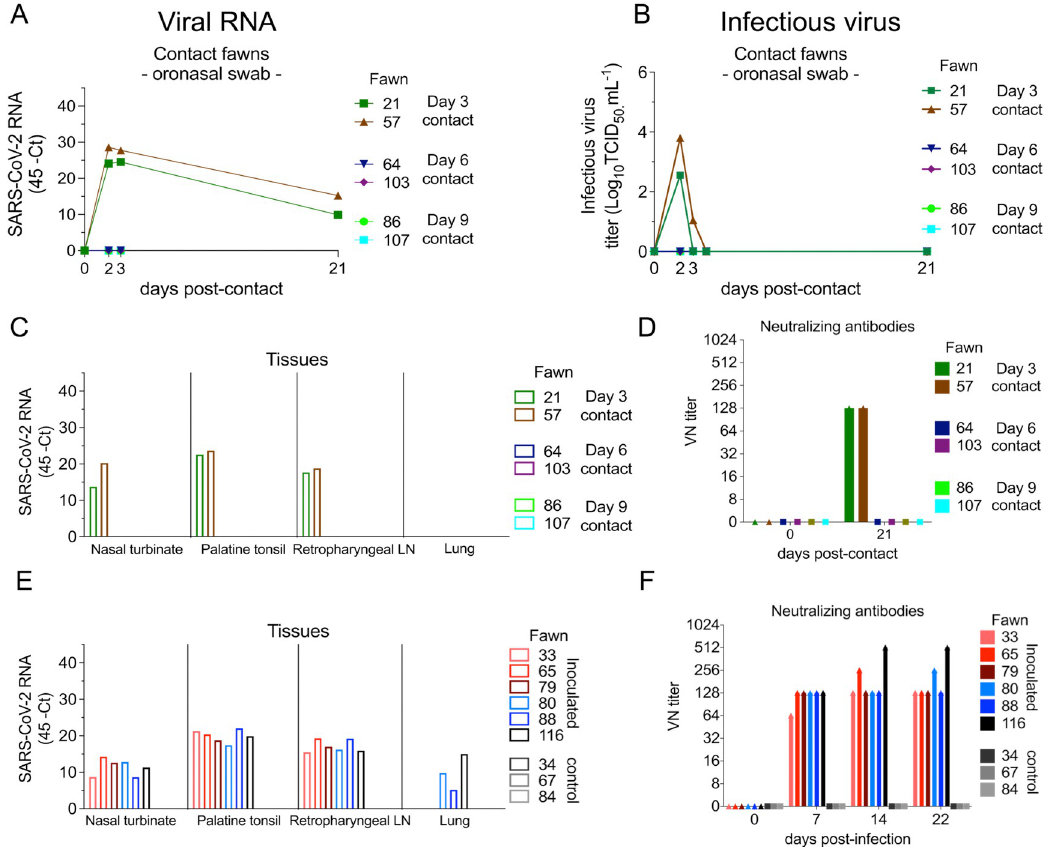
Fig 3. Viral load in oronasal secretions, and seroconversion in contact white-tailed deer. A ) Virus shedding (viral RNA load) assessed in oronasal secretions of day 3- (animals no. 21 and 57), day 6- (animals no. 64 and 103), and day 9 contact (animals no. 86 and 107) fawns. Oronasal swabs collected on days 0 (before contact), days 2, 3 and 21 post- contact (pc) were tested for the presence of SARS-CoV-2 RNA by real-time reverse transcriptase PCR (rRT-PCR). B ) Shedding of infectious SARS-CoV-2 in oronasal secretions was assessed by virus titrations in rRT-PCR-positive samples. Virus titers were determined using end point dilutions and expressed as TCID 50 .ml -1 . C ) Tissue distribution of SARS-CoV-2 RNA assessed in nasal turbinate, palatine tonsil, retropharyngeal lymph node, and lung collected and processed for rRT-PCR 21 d pc of contact fawns. D ) Antibody responses following contact of fawns with inoculated animals was assessed by virus neutralization (VN) assay. Neutralizing antibody titers were expressed as the reciprocal of the highest dilution of serum that completely inhibited SARS-CoV-2 infection/replication. E ) Tissue distribution of SARS-CoV-2 RNA assessed in nasal turbinate, palatine tonsil, retropharyngeal lymph node, and lung collected and processed for rRT-PCR 22 days post-inoculation (d pi). F ) Antibody responses following SARS-CoV-2 inoculation assessed by VN assay. Neutralizing antibody titers were expressed as the reciprocal of the highest dilution of serum that completely inhibited SARS-CoV-2